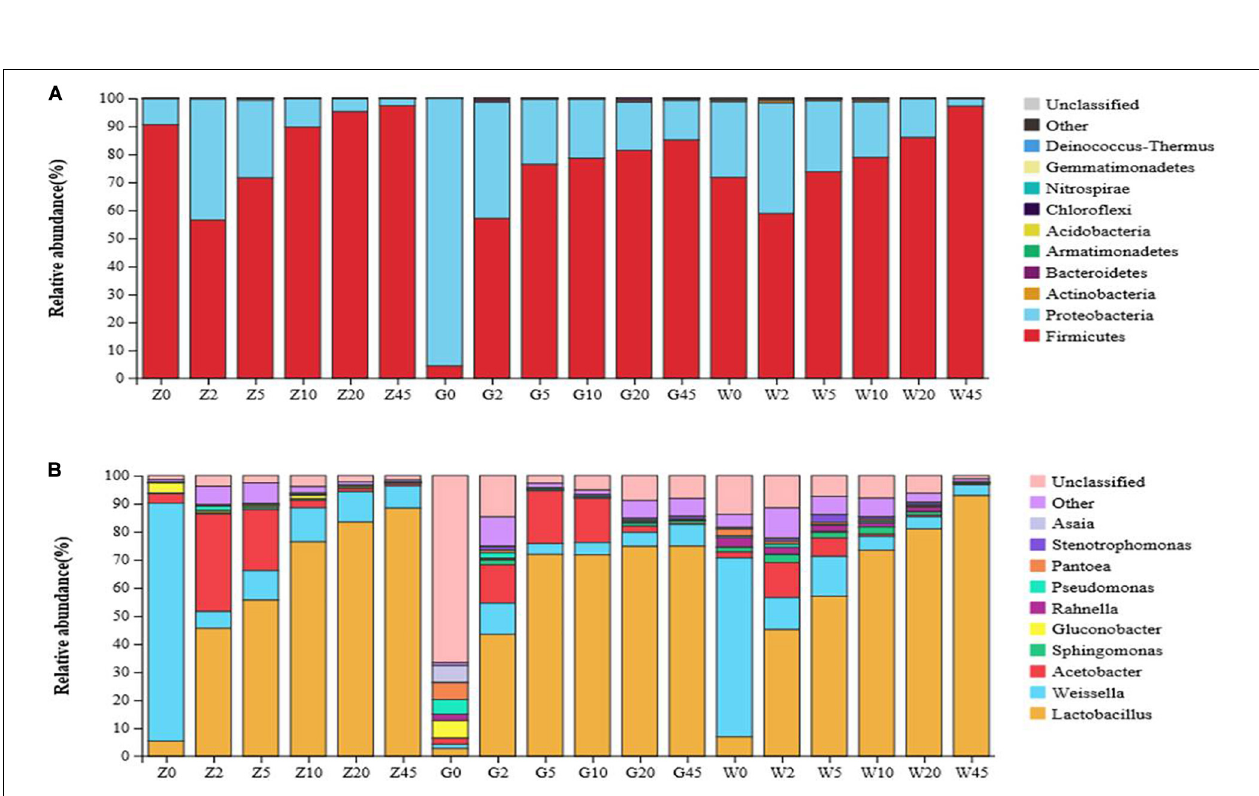
FIGURE 4 | The relative abundance of bacteria community proportions at the phylum (A) and genus (B) level across the treatments (as a percentage of the total sequence).